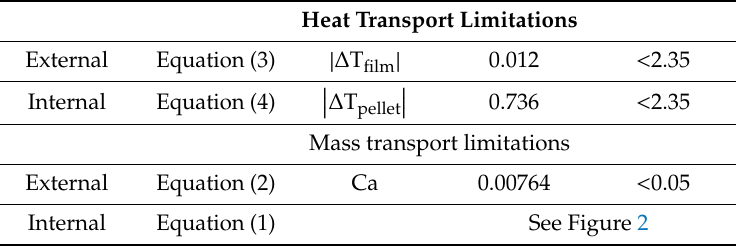
Table 1. External and internal heat and mass transport limitations in an industrial ethanol dehydration